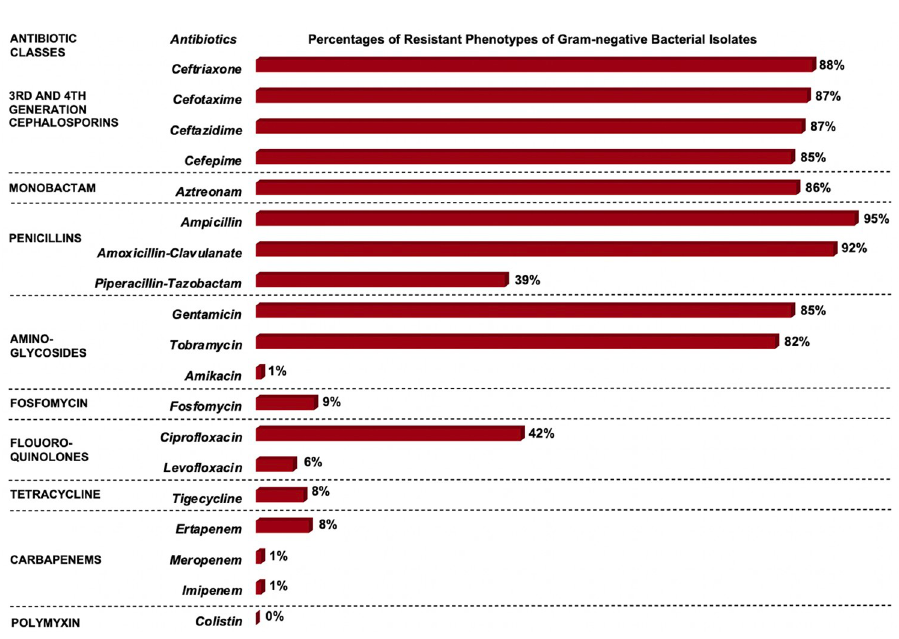
PLOS ONE | https://doi.org/10.1371/journal.pone.0255410 August 3,